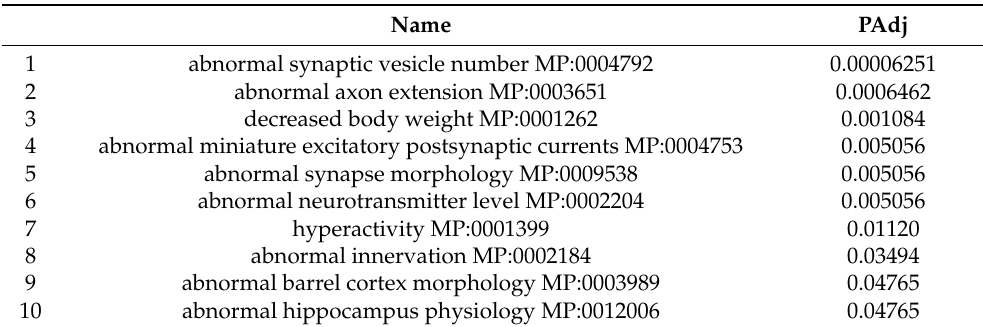
Table 5. Top 10 most significant MGI Mammalian Phenotype terms for the DEP list of 16-week L-NAME-untreated and -treated hippocampal tissue of C57BL/6 mice. Terms are ranked by p -value from most significant to least significant.